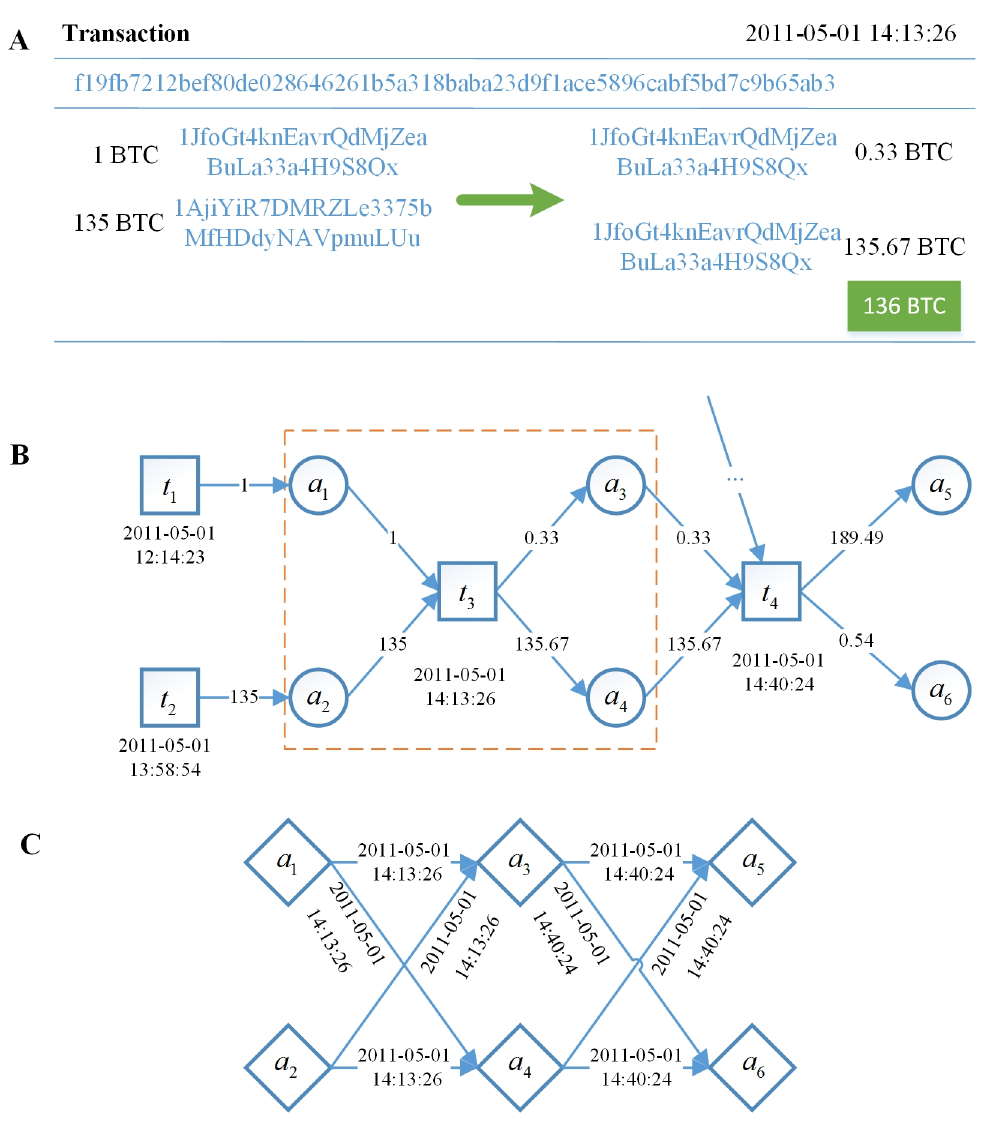
Fig 1. Illustration of transaction network construction. (A) An example of Bitcoin transaction details. (B) Example information extracted from Bitcoin transactions, and the information in the orange box correspond to the transaction in (A). (C) The Bitcoin transaction network as a directed